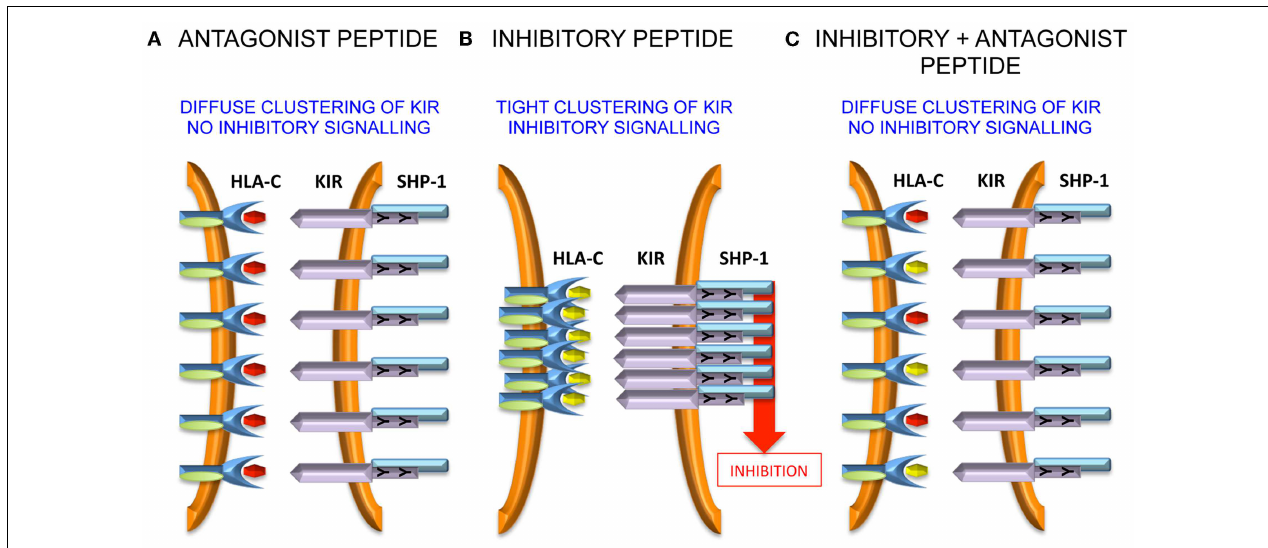
there is no inhibitory signal generated. (B) An inhibitory peptide induces tight clustering of KIR, SHP-1 recruitment, and inhibitory signaling. (C) The antagonist peptide abrogates tight clustering and thence inhibitory